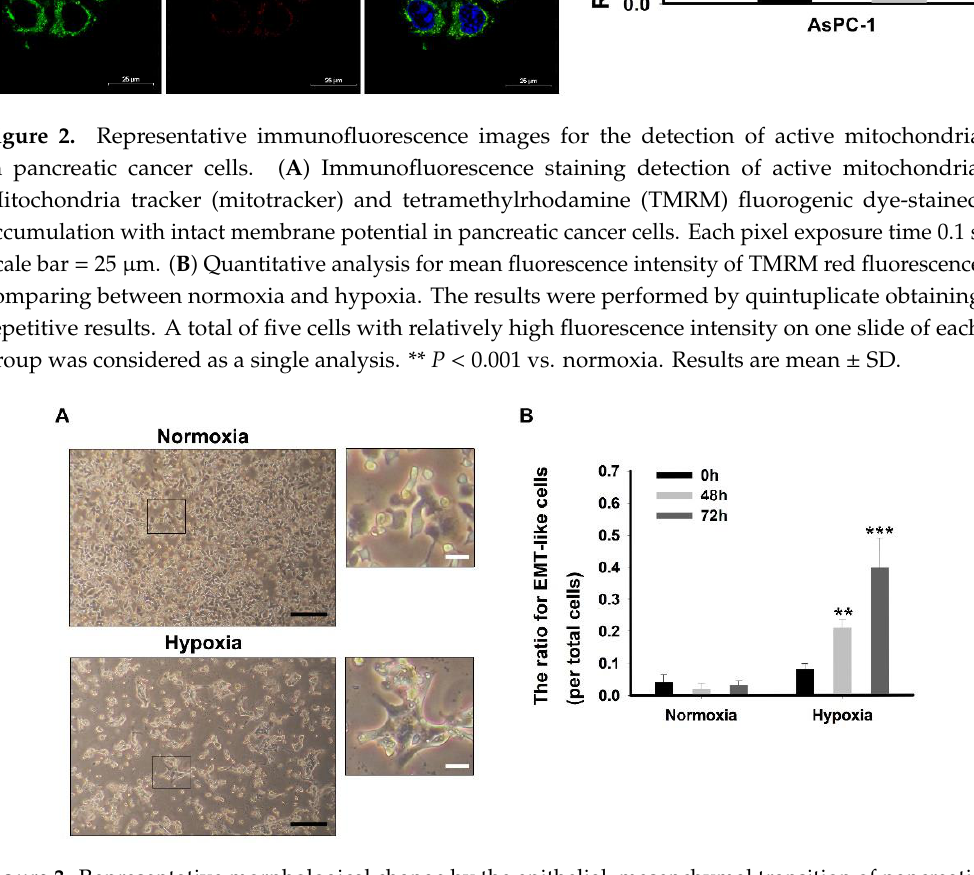
Figure 3. Representative morphological change by the epithelial–mesenchymal transition of pancreatic cancer cells. ( A ) Representative optical microscope pictures of the pancreatic cancer cells under hypoxia. Black scale bar = 50 μm; White scale bar = 10 μm. ( B ) Quantitative analysis for the ratio of epithelial to mesenchymal transition like cells per total cells. The results were performed by quintuplicate obtaining repetitive results. ** P < 0.001 vs. all normoxia and 0 h hypoxia; *** P < 0.001 vs. all normoxia, 0 h hypoxia, and 48 h hypoxia. Results are mean ± SD.